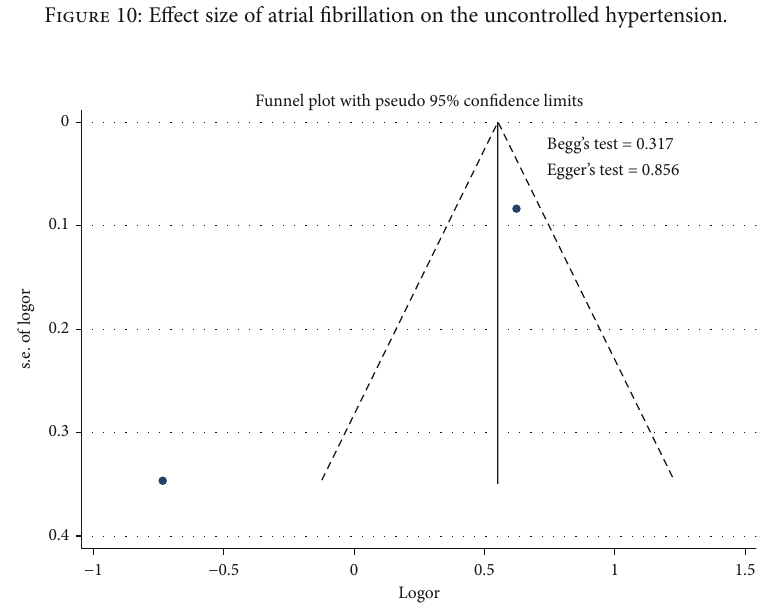
Figure 11: Funnel plots role of atrial fi brillation on the uncontrolled